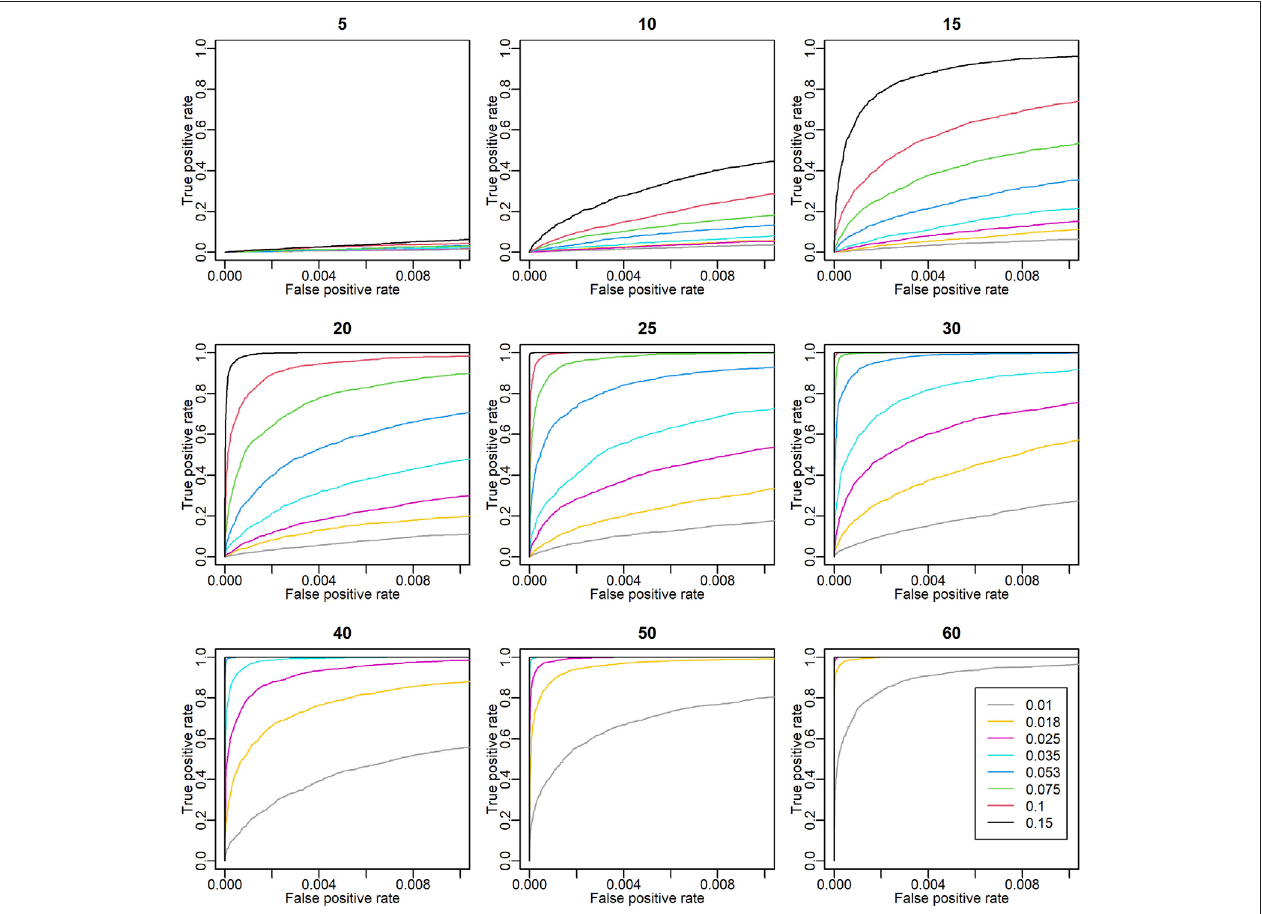
FIGURE3| Receiver operating characteristic (ROC) curves in simulation analyses. The titles of the plots denote the number of environments ( M ). The ROC curves of different r 2 values are drawn with different colours. The x and y axes are the false positive rate and the true positive rate, respectively. In these simulations, 99 true negatives were simulated for each true positive. Thus, the coordinate (x, y) (cid:2) (1, 0.01) means that one true positive is detected with 0.99 false positives.